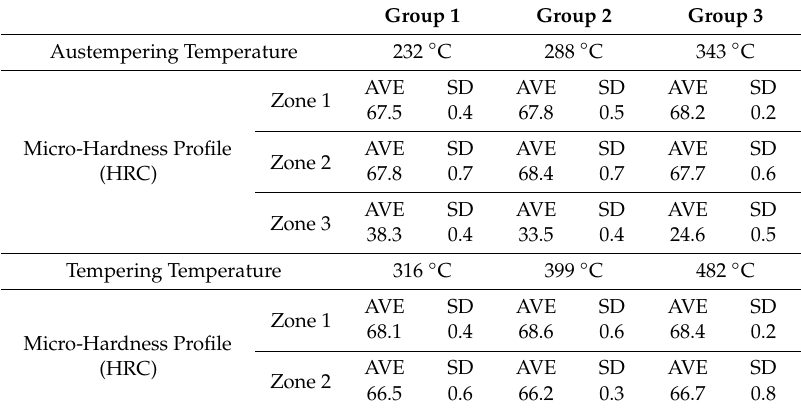
Micro-Hardness Profiles of the LHAGI and LHQTGI Specimens with Various Heat Treatment Designs.